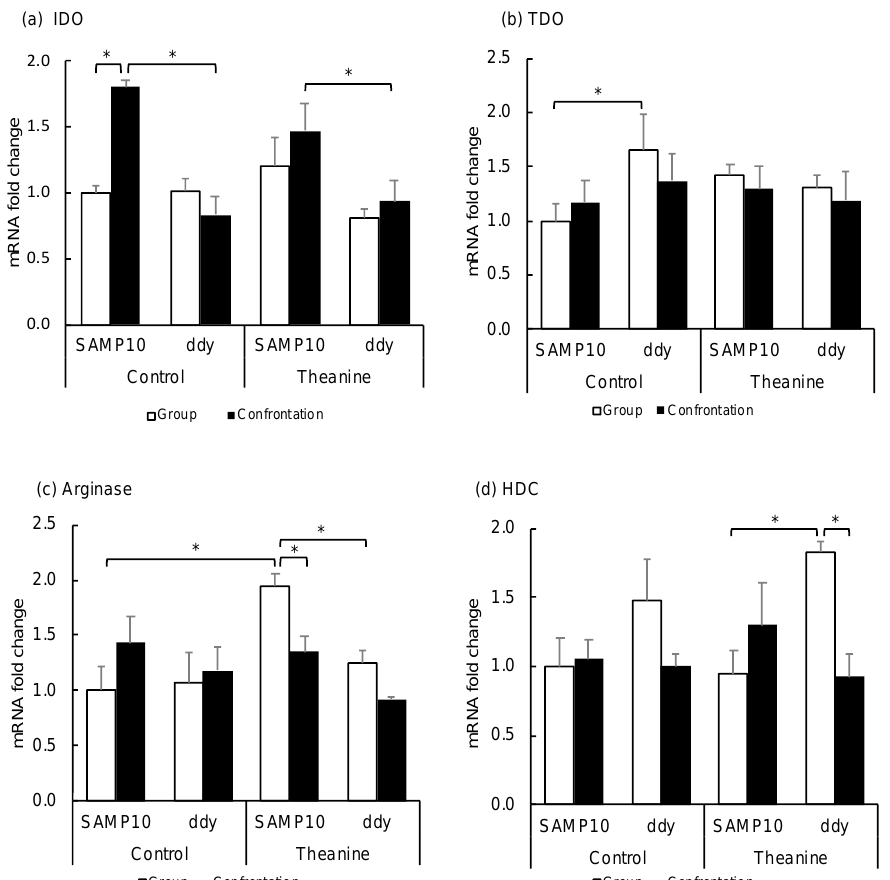
Figure 4. Effect of theanine intake on mRNA expression of SAMP10 and ddY mice under group or confrontational housing. ( a ) Indoleamine-2,3-dioxygenase (IDO); ( b ) Tryptophan-2,3-dioxygenase (TDO); ( c ) Arginase; ( d ) Histidine decarboxylase (HDC). Mice were housed confrontationally for one month after single housing for one month (closed column). Group-housed mice were kept in a group of four for two months (open column). Mice ingested theanine (20 µg/mL, 6 mg/kg) or water (control) for two months ( n = 4, *, p < 0.05).